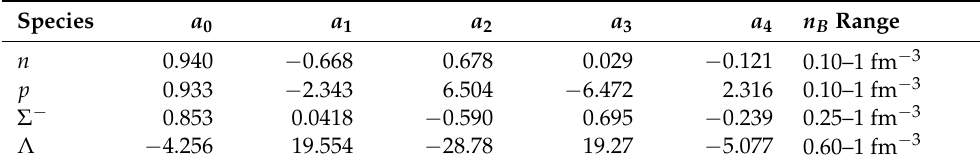
Table A1. Coefficients of the polynomial fit (A1) for NSC97e model. Last column gives the density range where the expression (A1) is valid.